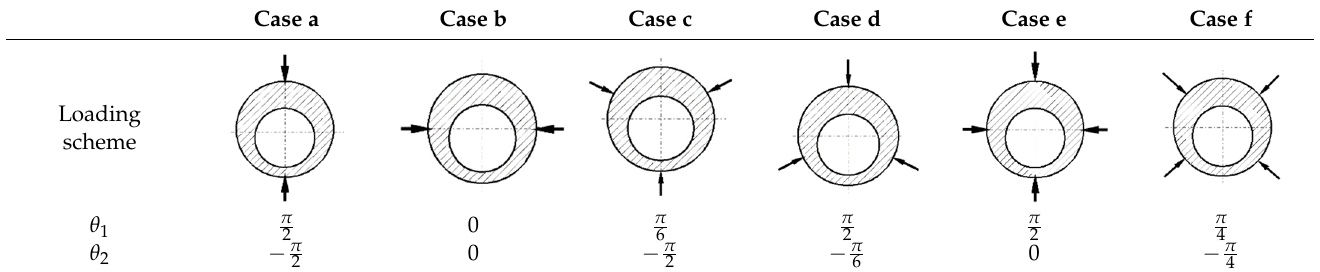
Table 1. Symmetrical loading schematics for an eccentric ring.